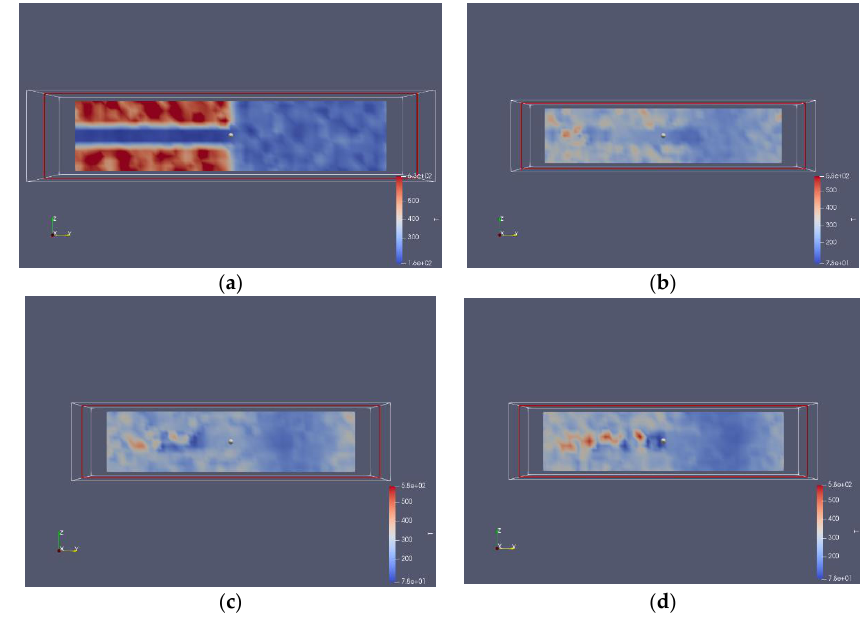
Figure 14. Temperature profile (unit: K) of nitrogen jet (7.5 MPa, 120 K) sprayed into supercritical argon environment (5.5 MPa, 200 K): ( a ) t = t 0 ; ( b ) t = t 0 + 25 ps; ( c ) t = t 0 + 50 ps; ( d ) t = t 0 + 100 ps.